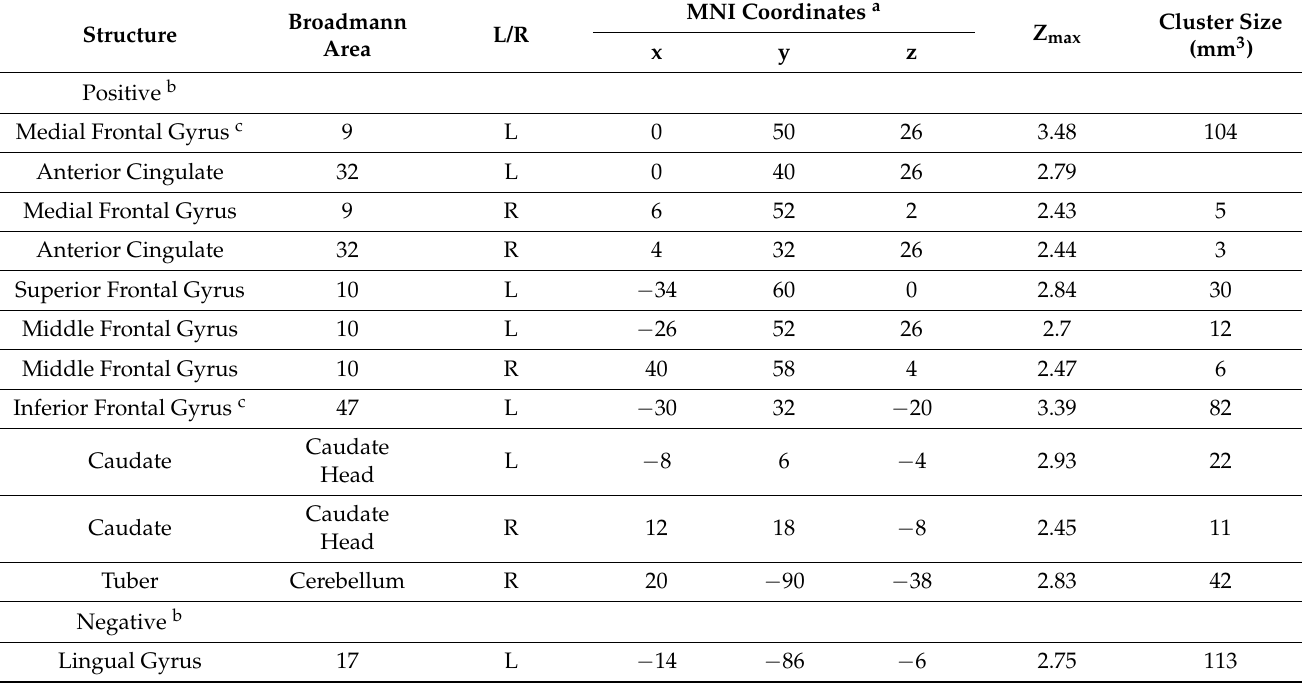
Table 4. Brain regions correlated with total CRS-R score in patient with